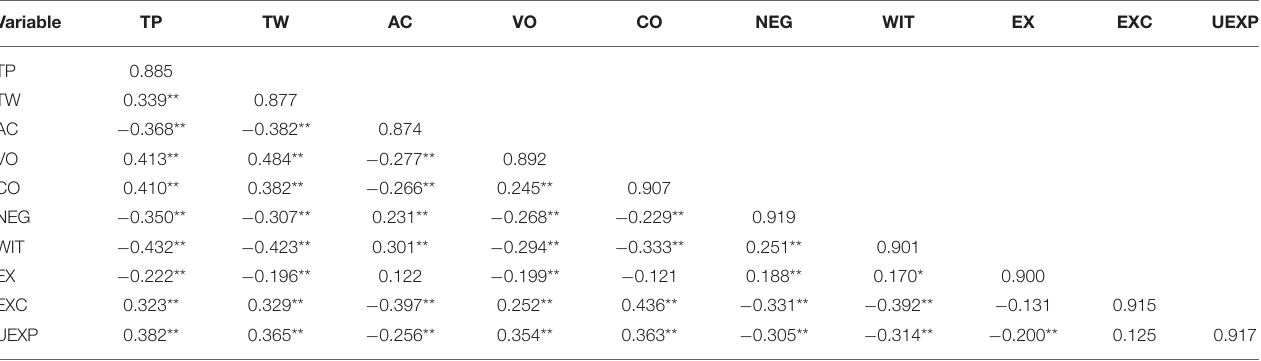
TABLE 2 | Discriminant validity test.